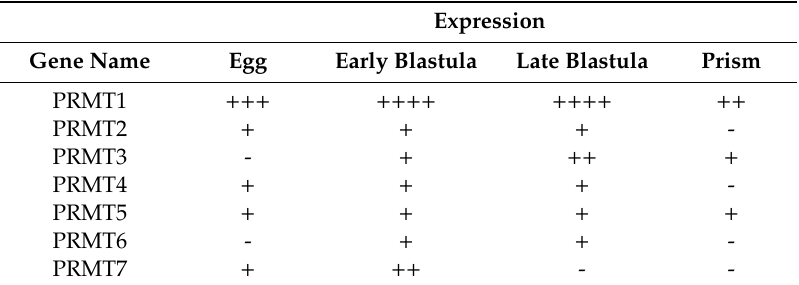
Table 4. PRMT genes and their expression during